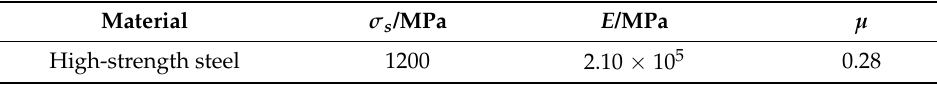
Figure 3. U-shaped carriage of dump truck. Table 1. Material basic properties of high-strength steel used for carriage. Table 1. Material basic properties of high-strength steel used for carriage.